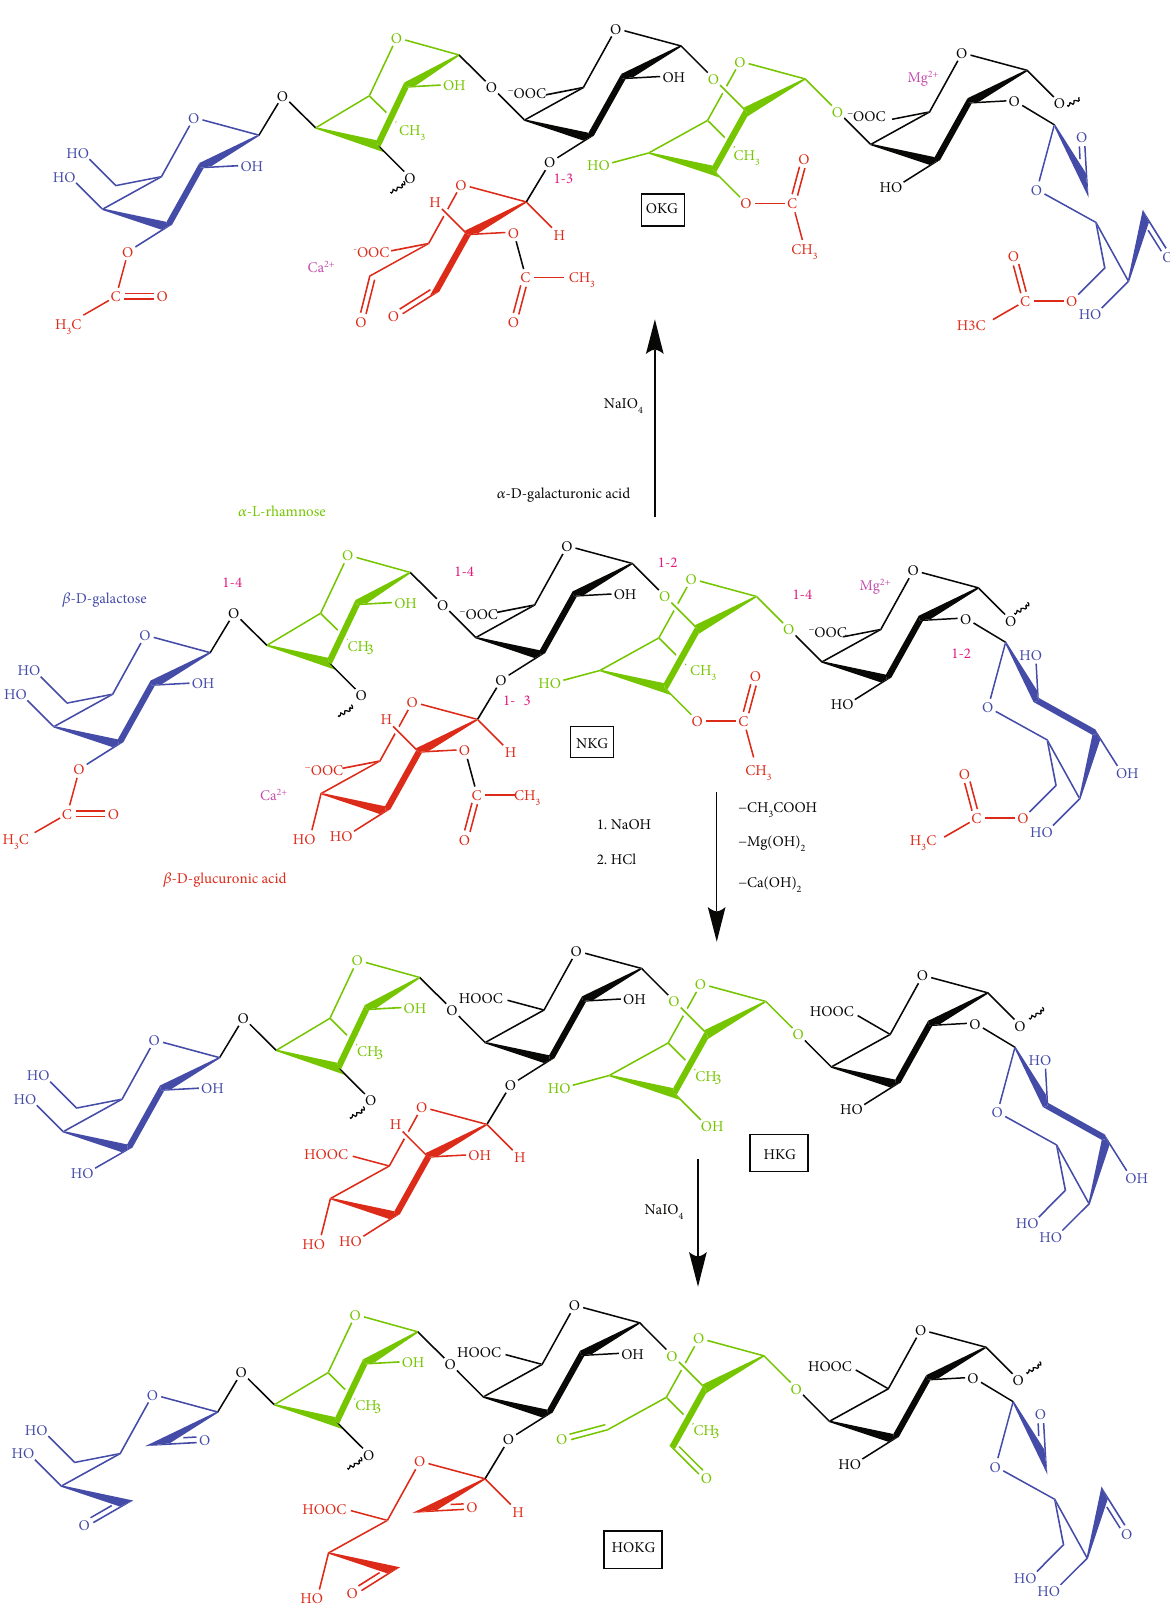
Figure 1: Structures of native (NKG), hydrolyzed (HKG), periodate oxidized (OKG), and hydrolyzed-periodate oxidized (HOKG) karaya